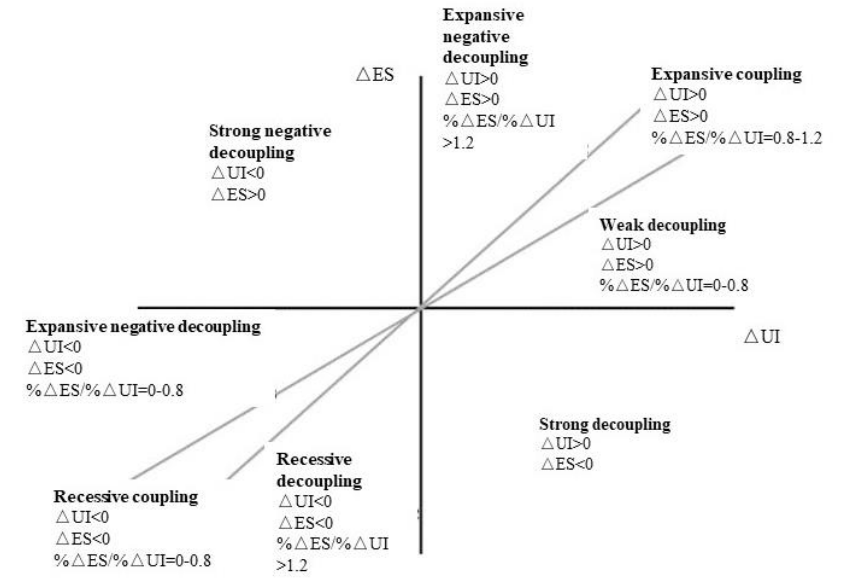
Figure 3. The degrees of coupling and decoupling of ESs from urbanization (modified from [54] ).